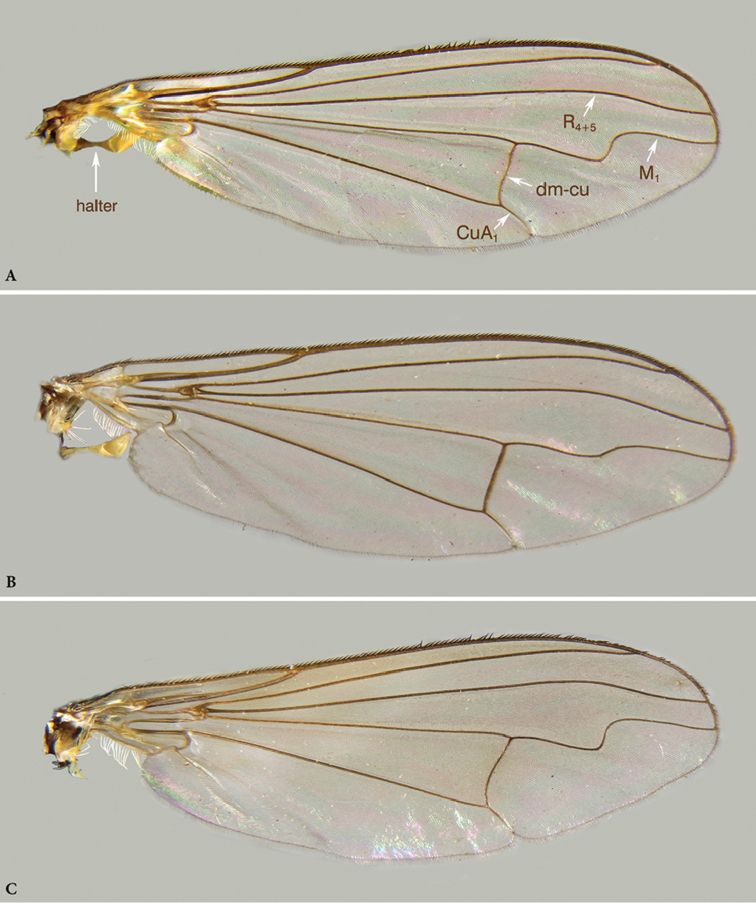
Orthoceratiumlacustre, wing and halter: A male B female. Orthoceratiumsabulosum: C wing (male). Veins R4+5, M1, CuA1, and dm-cu indicated.